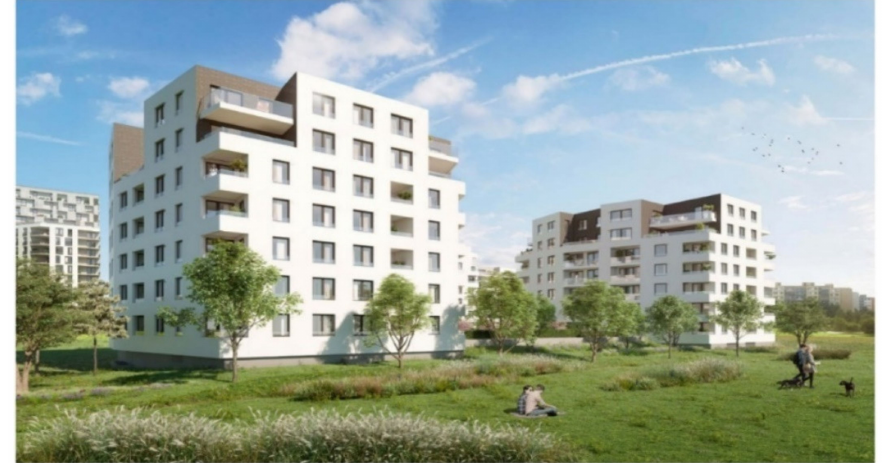
Figure 1. Civic assessment structure (case study)